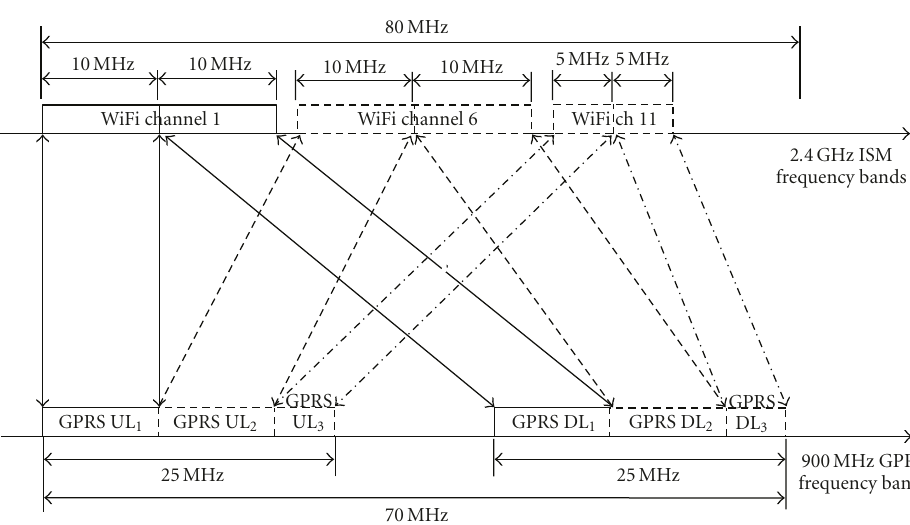
designed for concurrent execution of multiple